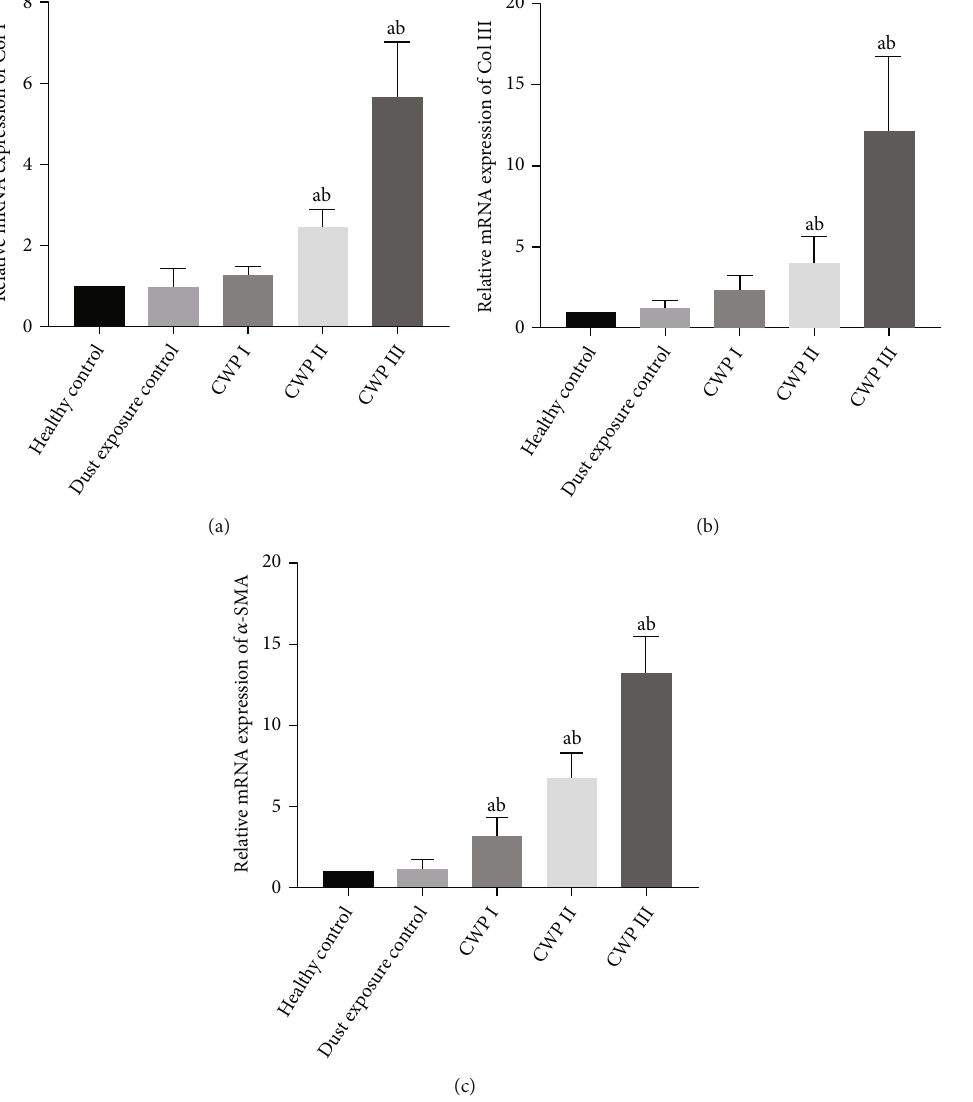
Figure 1: Relative expression level of fi brosis-related genes. (a) The relative mRNA expression levels of Col I . (b) The relative mRNA expression levels of Col III . (c) The relative mRNA expression levels of α -SMA . a P < 0 : 05 , compared with the healthy control group. b P < 0 : 05 , compared with dust exposure control